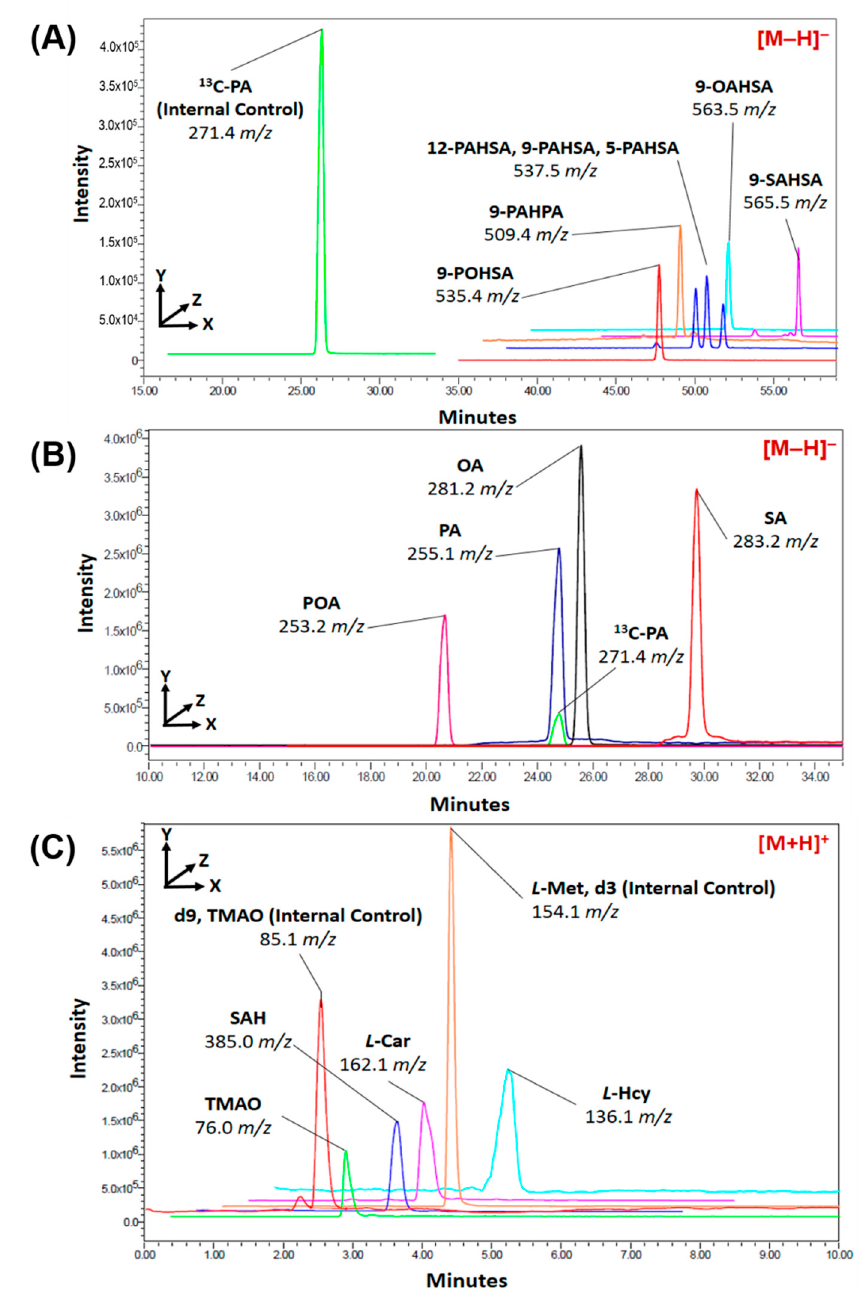
Figure 2. Determination of fatty acid esters of hydroxy fatty acids (FAHFAs), long-chain fatty acids, and cardiovascular (CV)-related biomarkers by using liquid chromatography-mass spectrometry (LC-MS). Seven types of circulating FAHFAs (5-PAHSA, 9-PAHSA, 12-PAHSA, 9-PAHPA, 9-SAHSA, 9-POHSA, and 9-OAHSA) ( A ), four long-chain fatty acids (PA, SA, POA, and OA) ( B ), and four non-traditional circulating CV-related biomarkers ( L -Hcy, SAH, L -Car, and TMAO) ( C ) were analyzed by LC-MS.